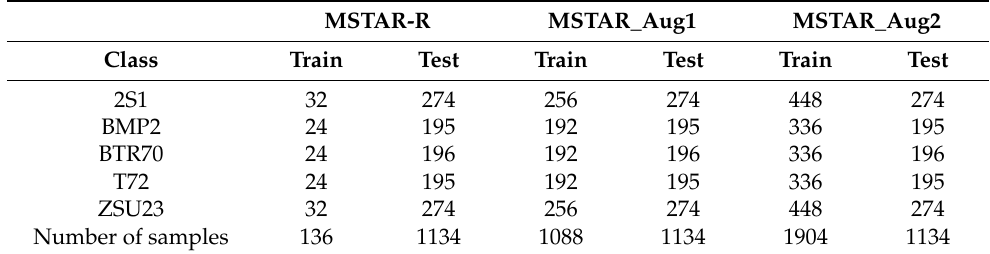
Table 2. Number of training image samples obtained via phase interpolation.